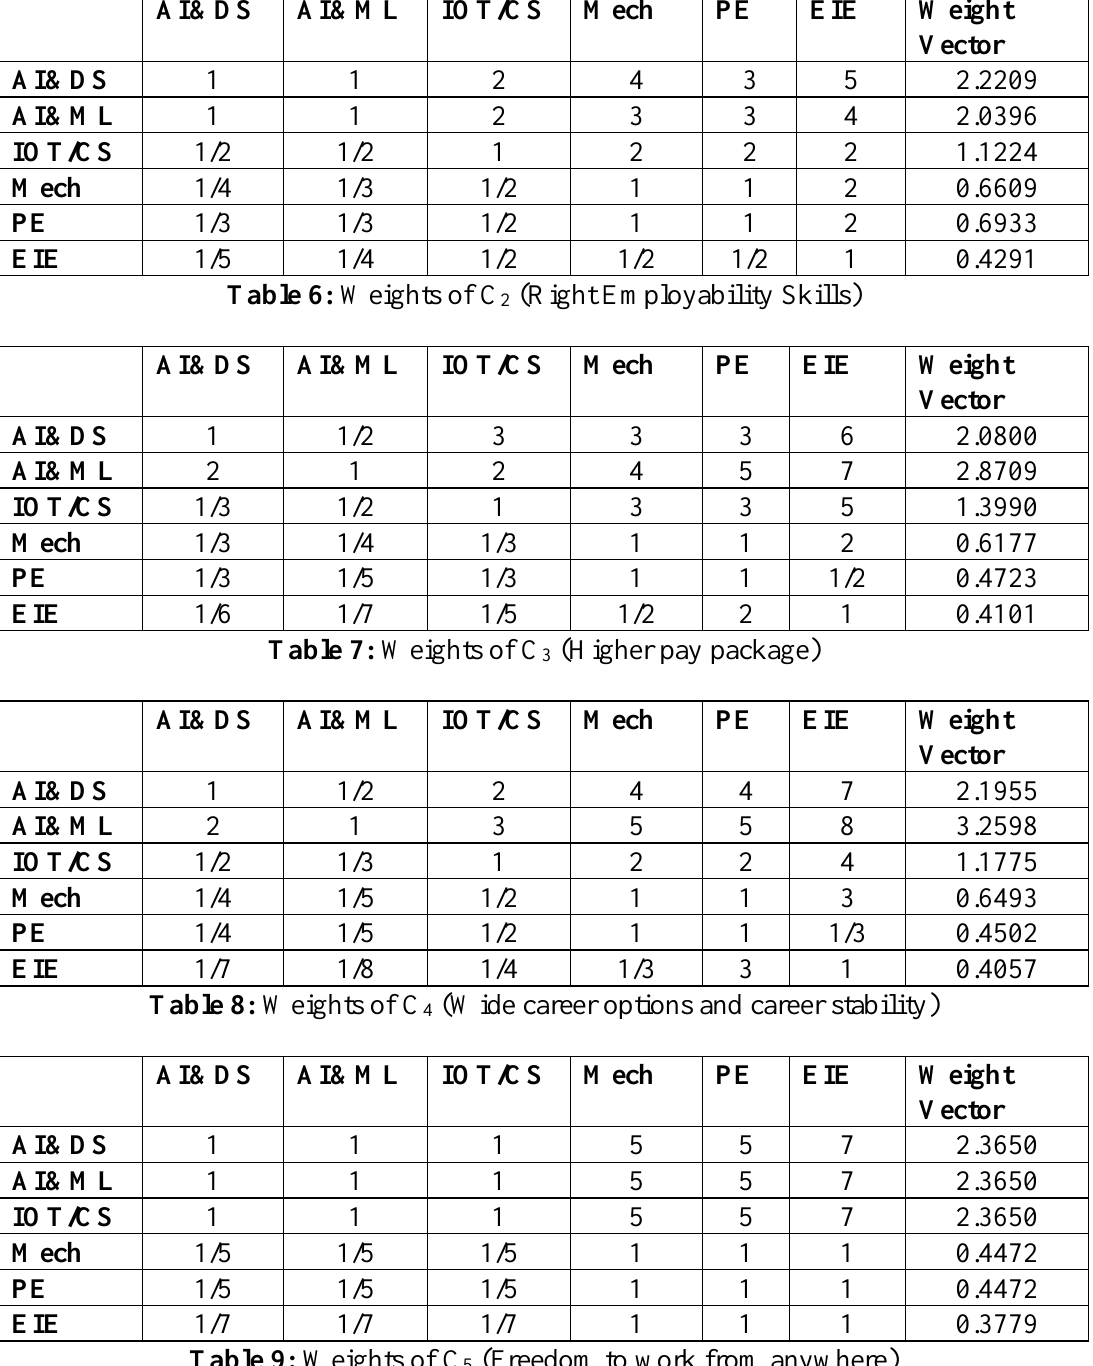
Table 9: Weights of C